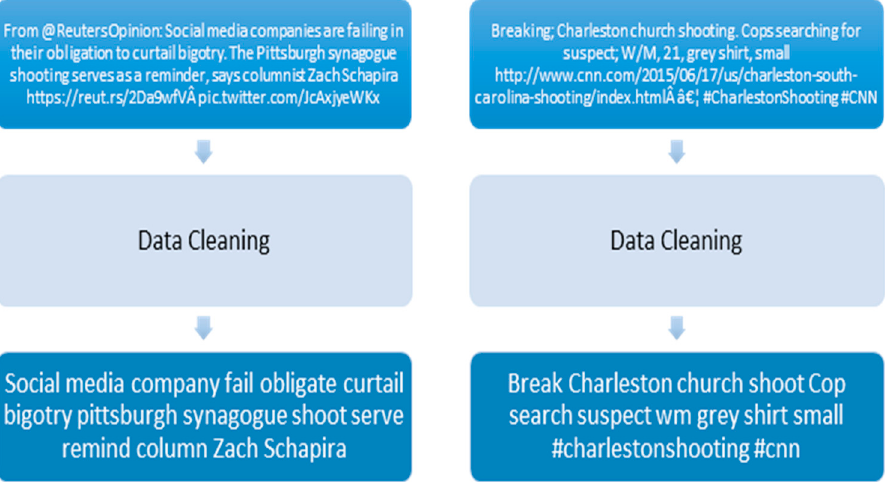
Figure 2. Sample tweets before and after cleaning and stemming.